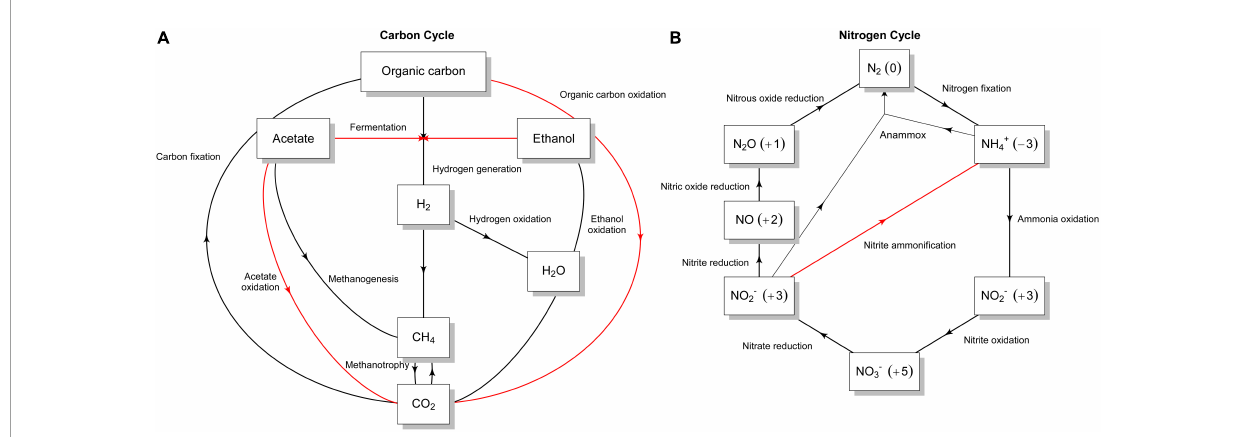
FIGURE5 Graphical representation of different sub-pathways of (A) carbon and (B) nitrogen metabolism in the Nit1536 T strain. The presence of the different sub-pathways is indicated with red arrows, while their absence is indicated with black arrows. The flow graphs were created using a modified script from METABOLIC (Zhou et al.,